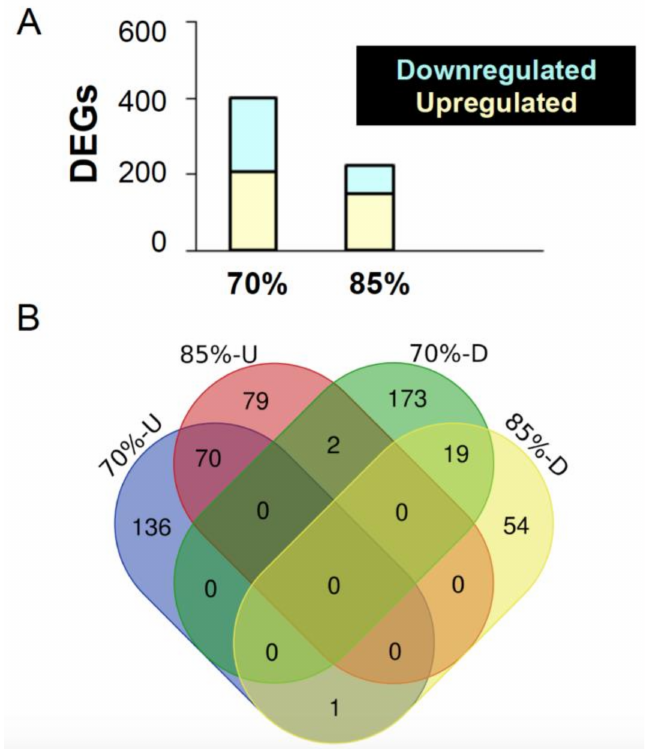
Figure 4. Overview of differentially expressed genes in the mid-intestine of the feed restricted groups (85% and 70%) in comparison to the 100% fed fish. ( A ) The graph shows the number of differentially expressed genes (DEGs) upon 70% and 85% feed restriction in comparison to the 100% fed group. ( B ) Venn diagrams showing the unique differentially expressed genes as well as genes shared between the two feed restricted groups (85% and